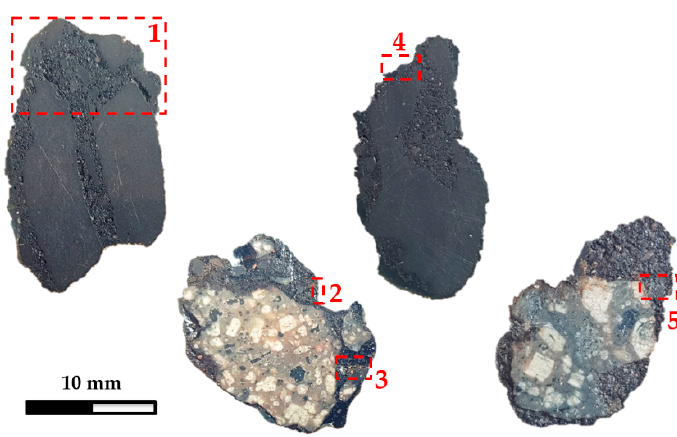
Figure 5. Procedure for determination of the chemical imaging.